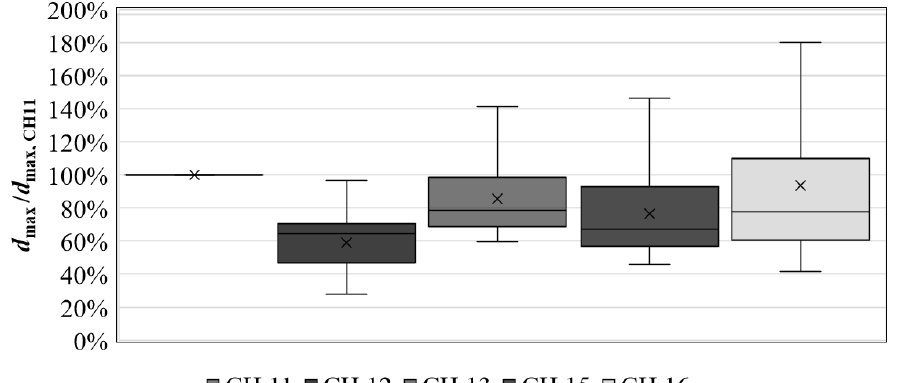
Figure 11. Box plot for the overtopping depth distribution of all channels standardized with overtopping depth measured in channel 11.